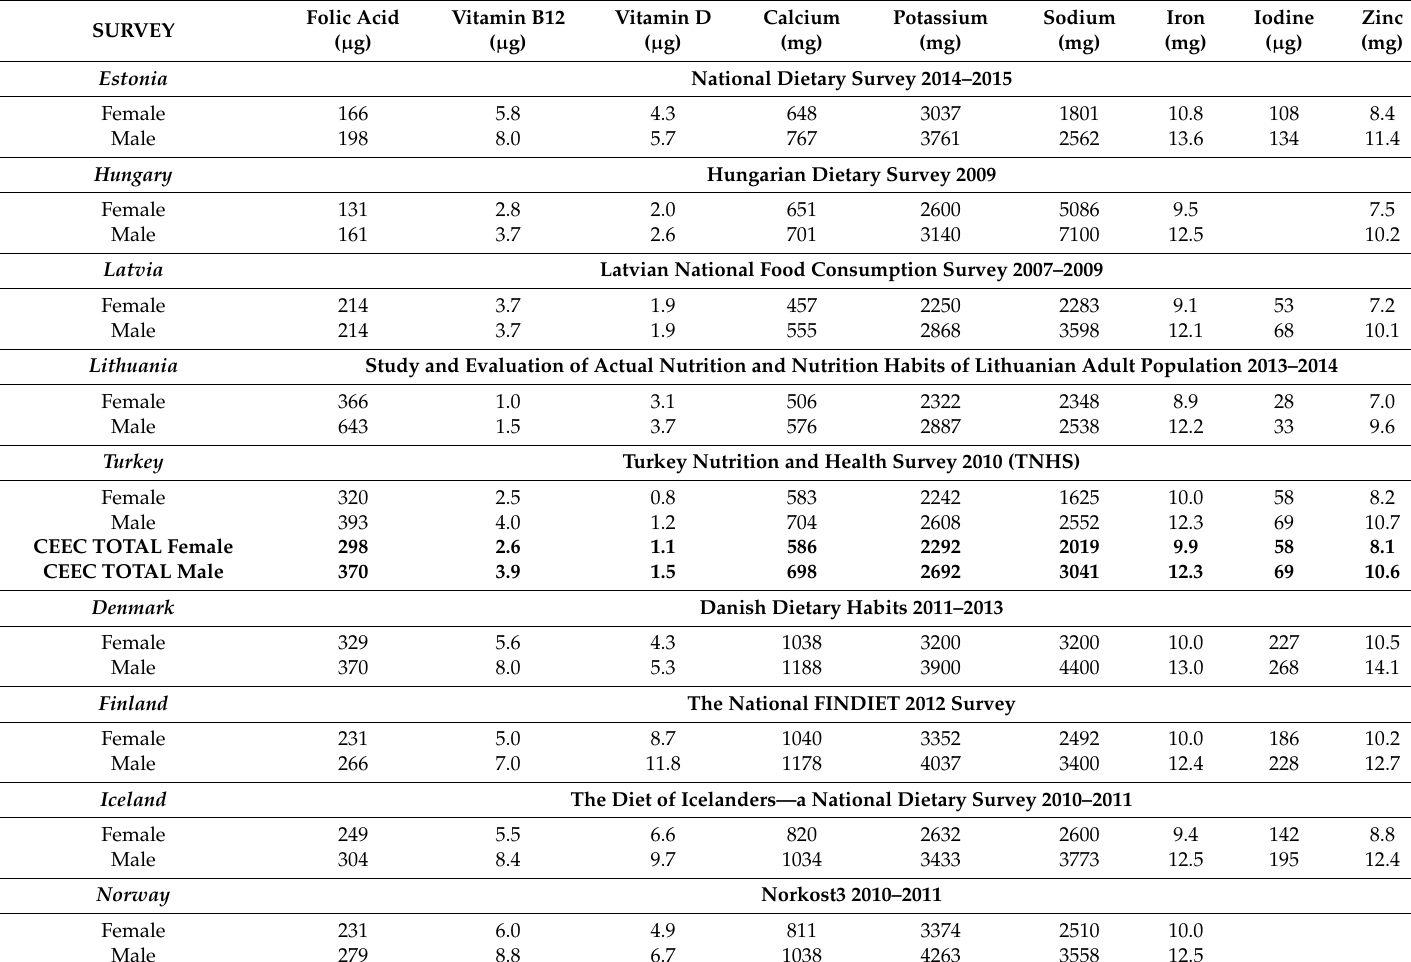
Table 5. Weighted means* by country for micronutrient in 21 national dietary surveys in the WHO Europe region.